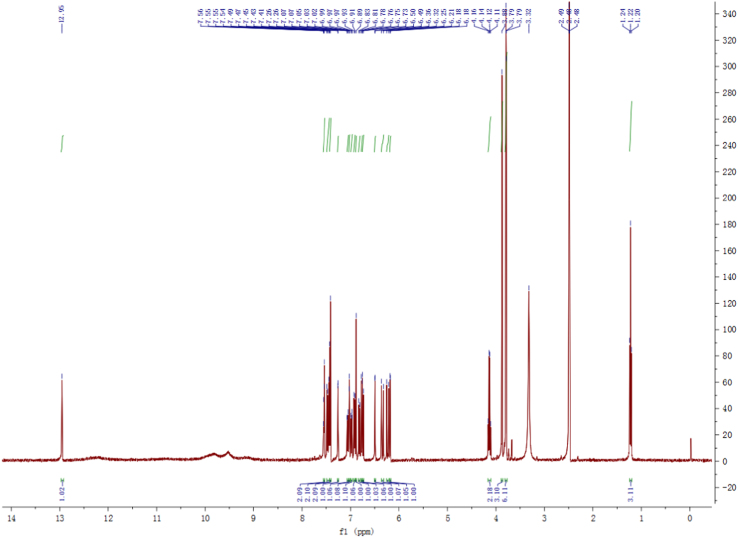
1H-NMR spectrum of compound 2.